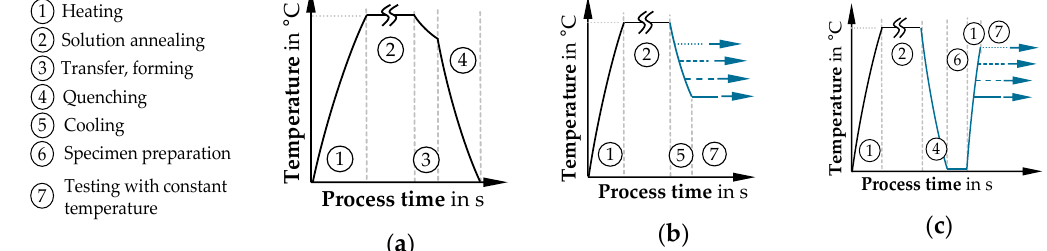
Figure 2. Thermal process routes for hot forming of 7000-series aluminum: ( a ) typical thermal process route for hot forming; ( b ) isothermal material testing immediately after solution annealing; ( c ) isothermal material testing after solution annealing, quenching and heating up to target temperature.